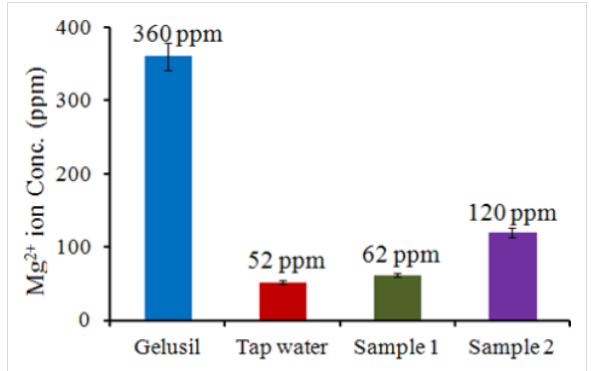
Figure 12: Measured concentration of Mg 2+ ions in real life samples. The error bars represent ±5%